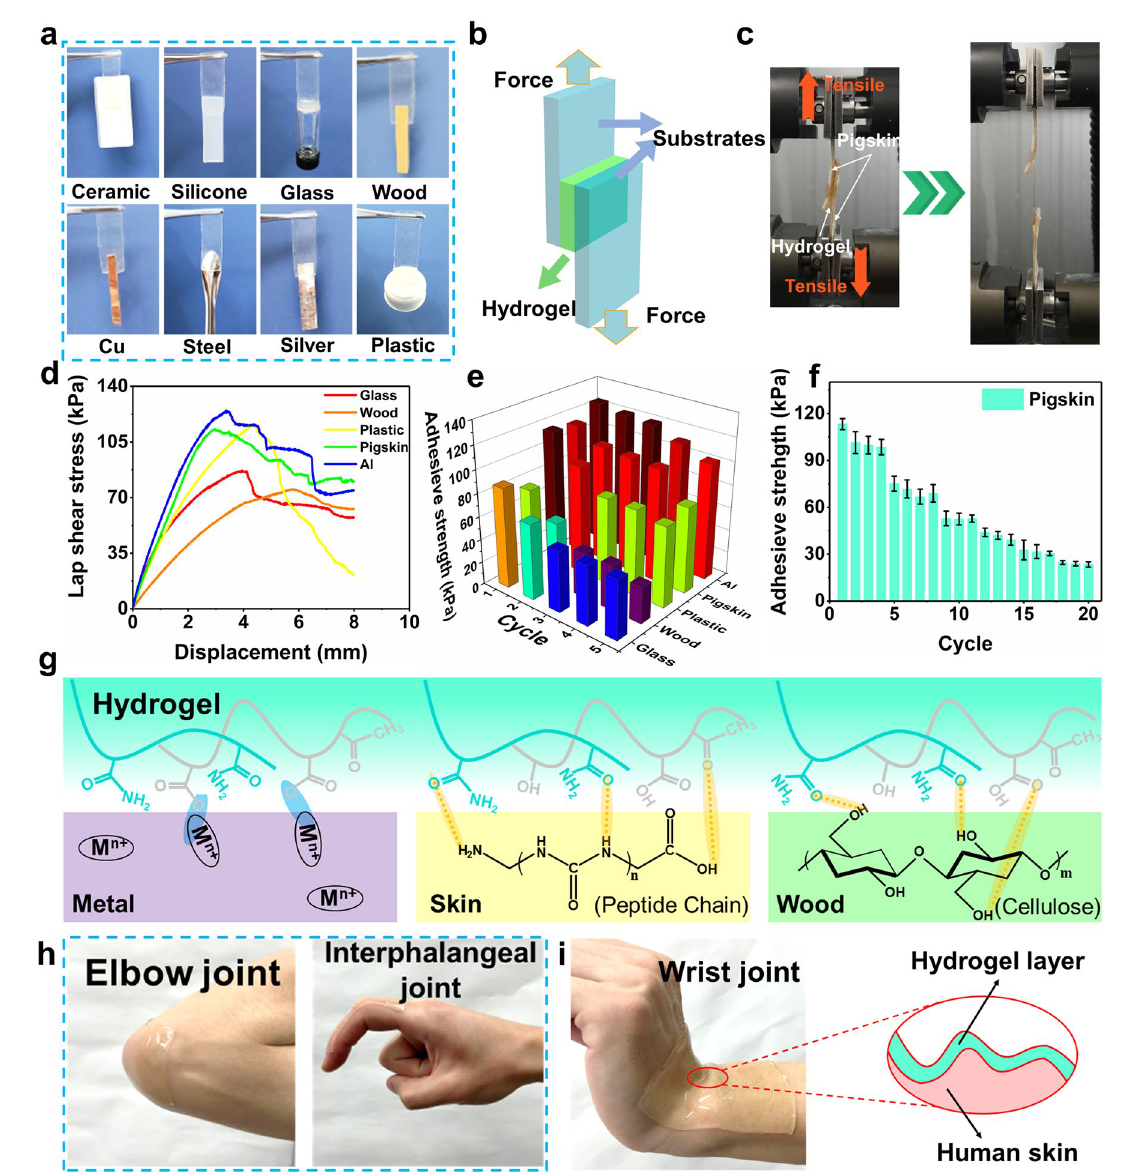
Fig. 4 a Photographs of C 11 T 4 A 20 hydrogel adhered on diverse substrates. b Schematic illustration of the lap shear test. c Photograph of lap shear test using pigskin as substrate. d Representative stress − displacement curves of lap shear tests on glass, wood, plastic, Al, and pigskin glued by C 11 T 4 A 20 hydrogel. e Adhesive strength and reusability of C 11 T 4 A 20 hydrogel on various substrates. f Adhesion durability and stability of